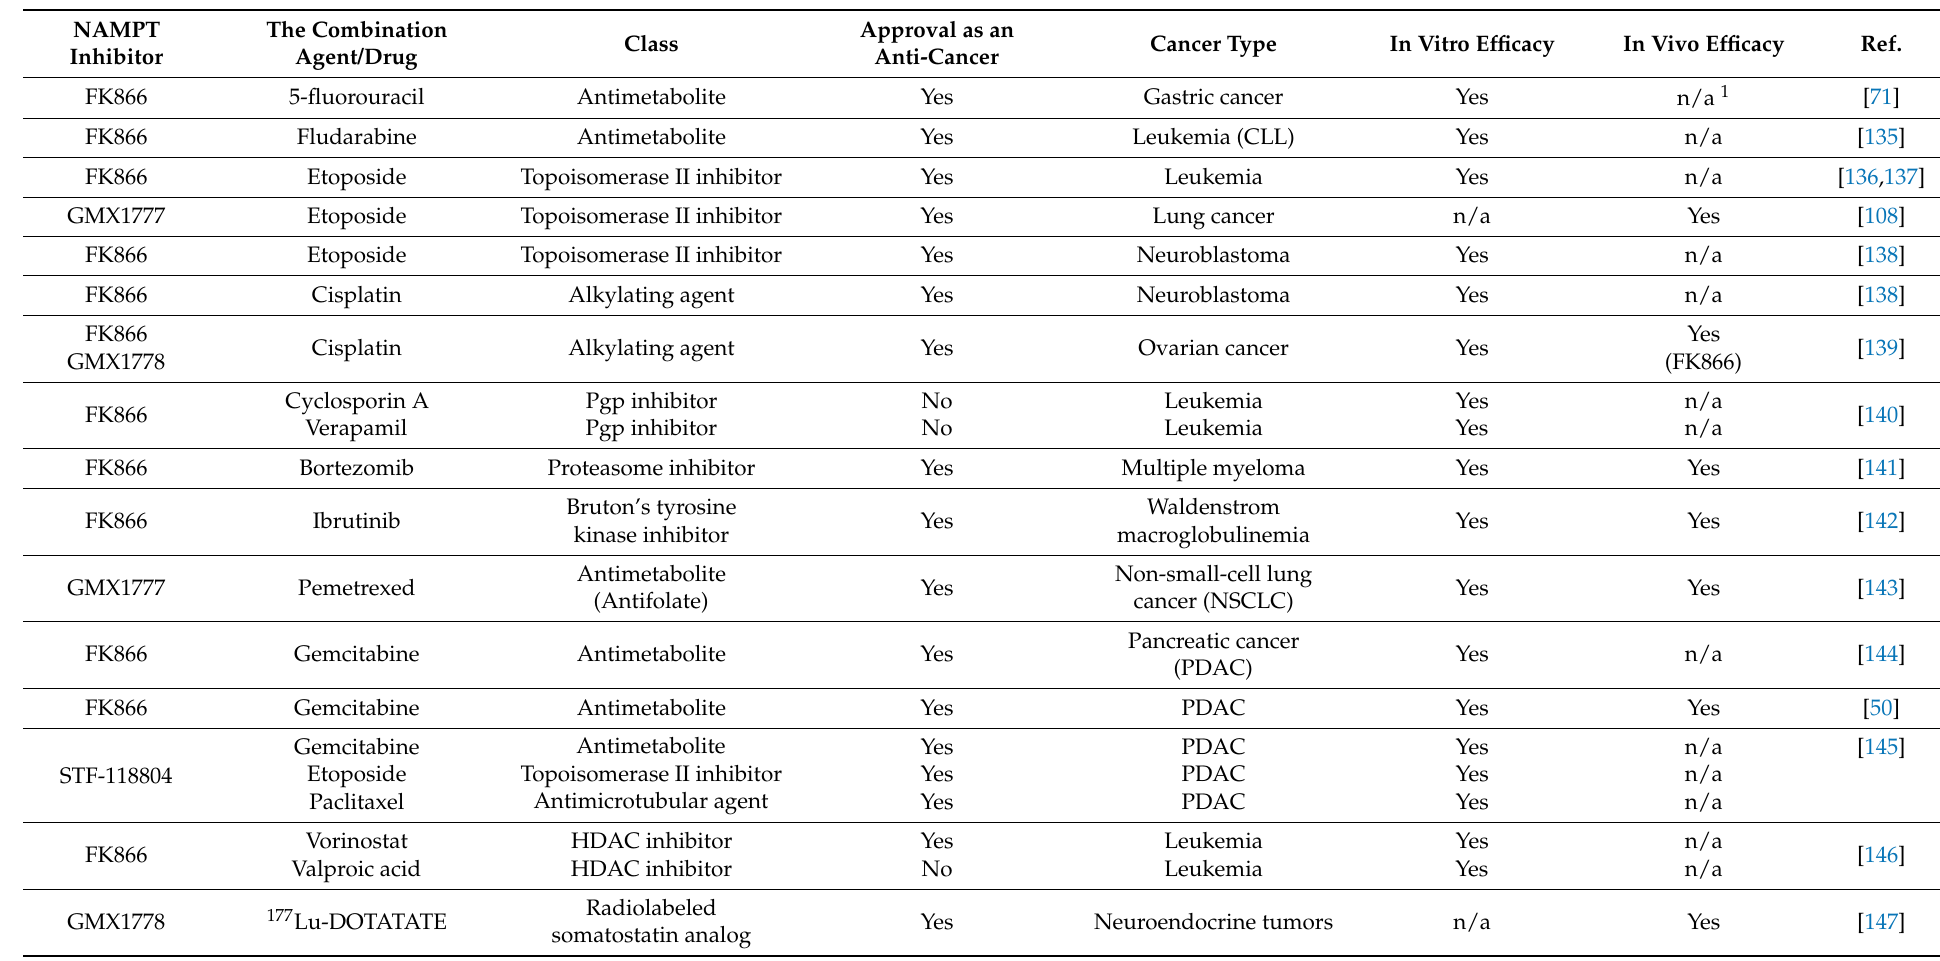
Table 2. Summary of the reported combinations of NAMPT inhibitors with other agents in cancer